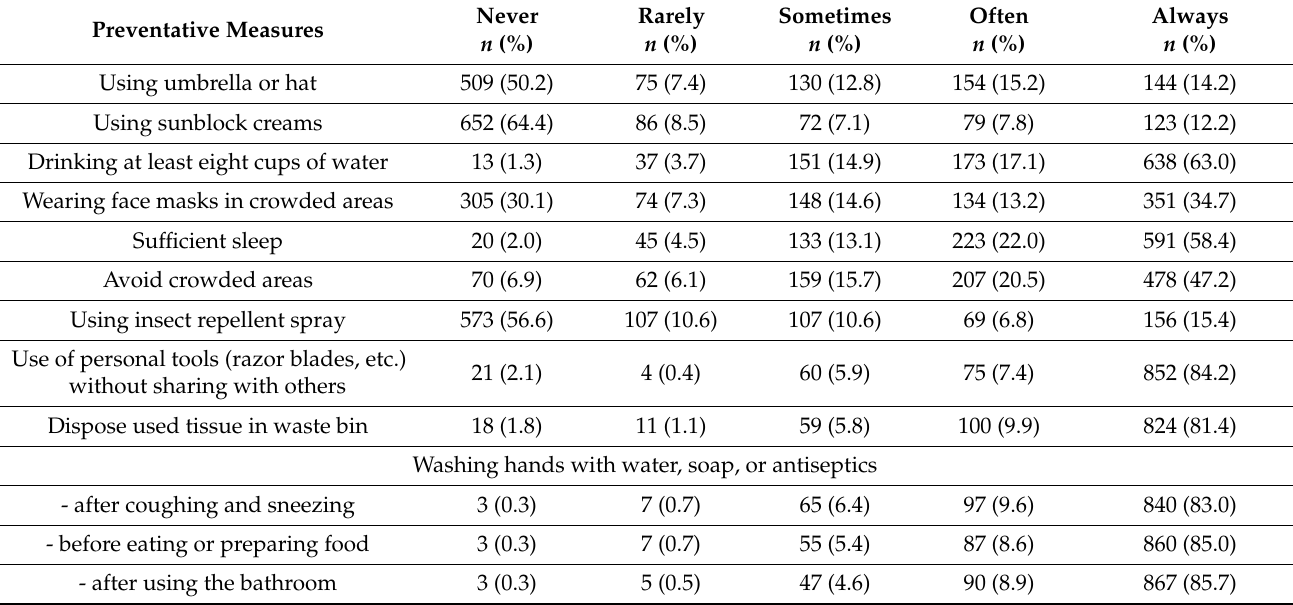
Table 5. Responses to items on aspects of practicing of preventative measures by pilgrims ( n = 1012).